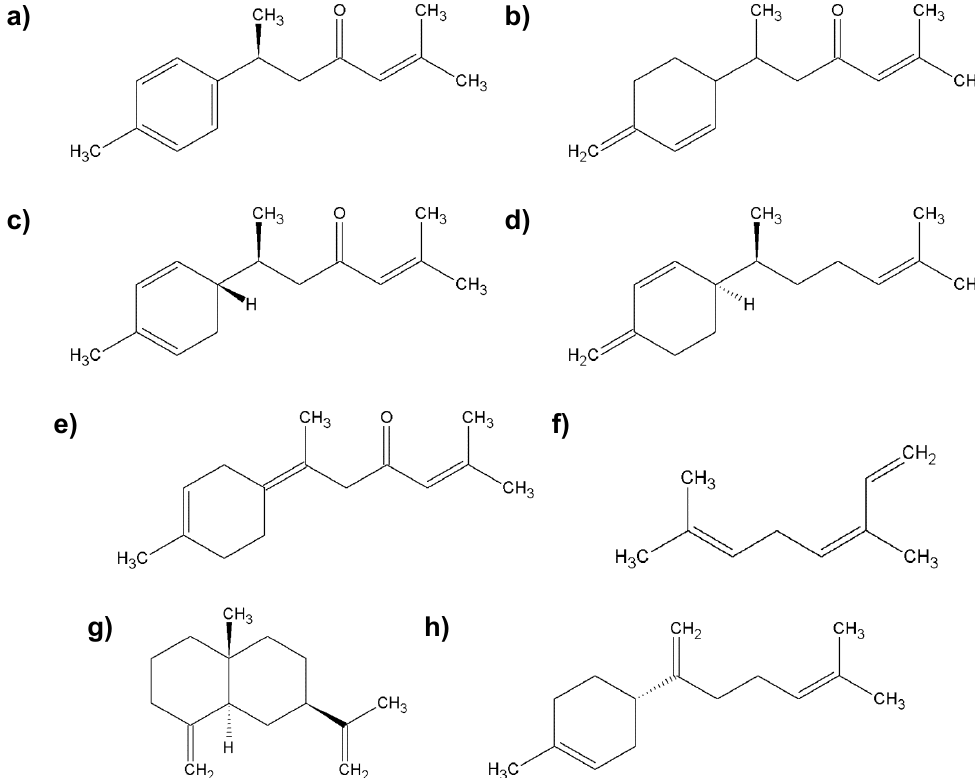
Figure 9. Characteristic compounds found in turmeric oil; ( a ) ar -turmerone; ( b ) β -turmerone; ( c ) α -zingiberene; ( d ) β -sesquiphellandrene; ( e ) ( E )- γ -atlantone; ( f ) ( Z )- β -ocimene; ( g ) β -selinene; ( h ) β -bisabolene.